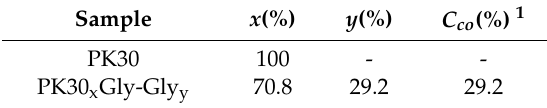
Table 1. Elemental analysis of pristine PK30 and PK30 after functionalization with